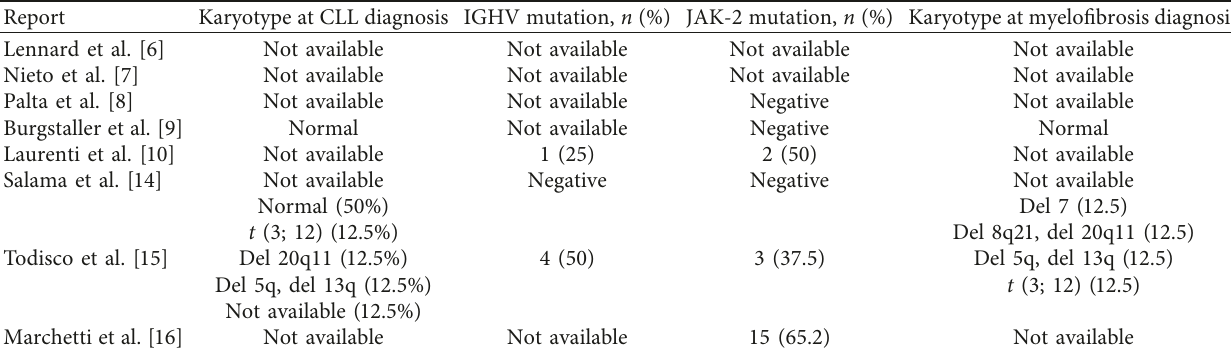
Table 2: Molecular characteristics of reported patients with CLL and